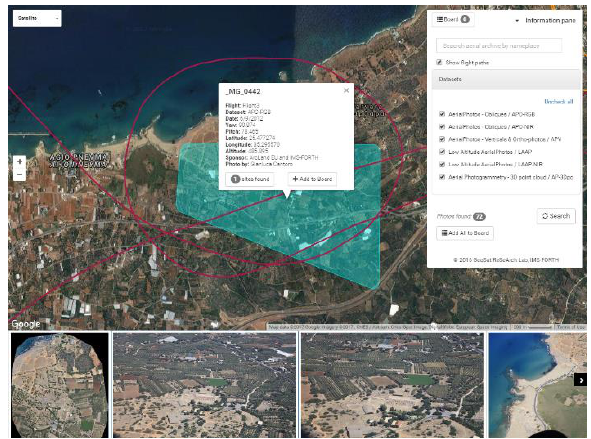
Figure 6: Screenshot of the WEB-GIS of the Aerial Archaeological Survey. Spatial queries automatically executed